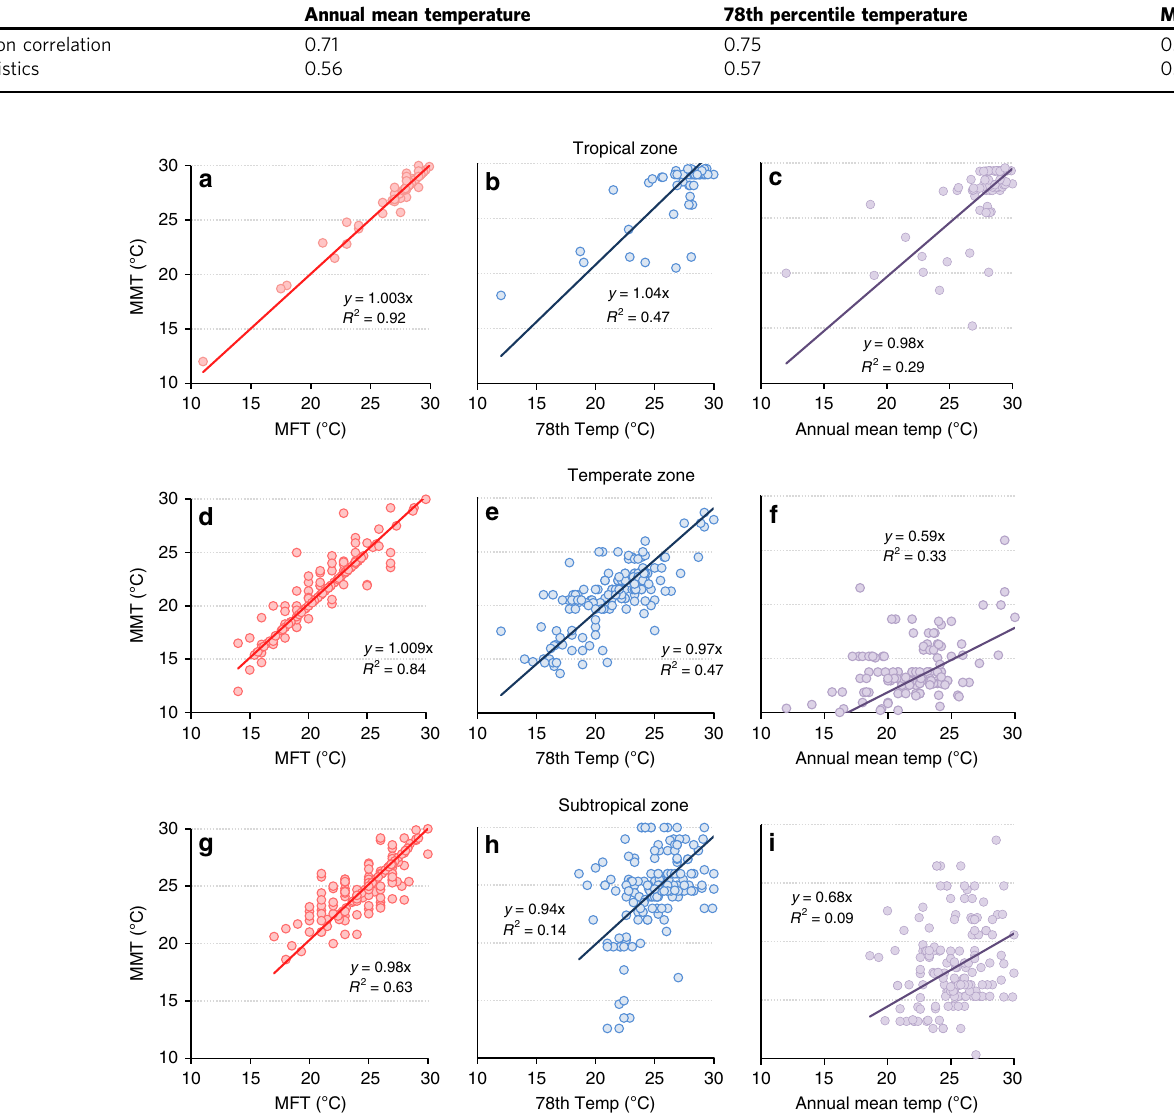
Fig. 3 Correlations of MFT, the 78th percentile temperature, annual mean temperature and MMT for three climatic zones. a – c for tropical zone. d – f for temperate zone. g – i for subtropical zone. The fi tting lines and performances are shown in the fi gures. MFT is proved to be the best indicator of MMT, particularly in tropical ( a ) and temperate regions ( d